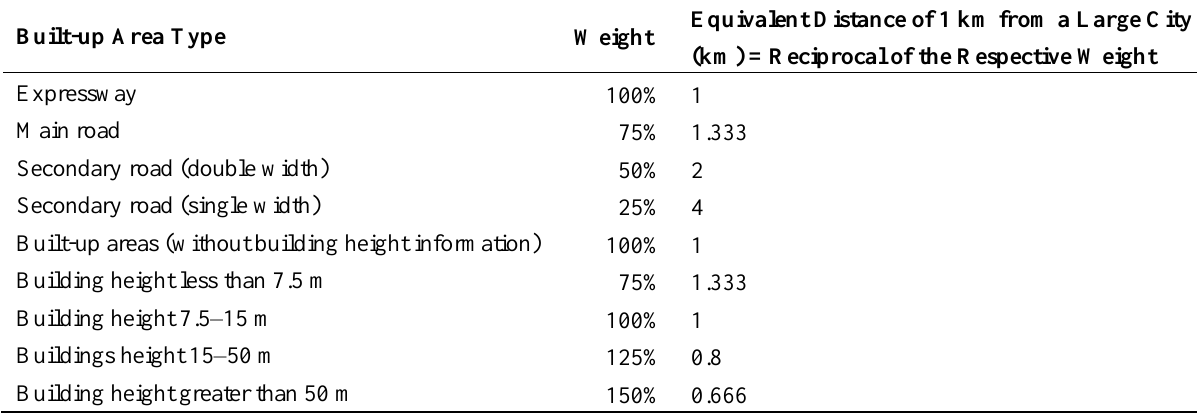
Table 2. Weights for different built-up areas and infrastructure categories, as applied in the landscape continuity value